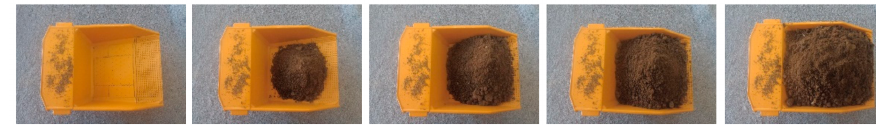
Figure 4. Part of the training set images.